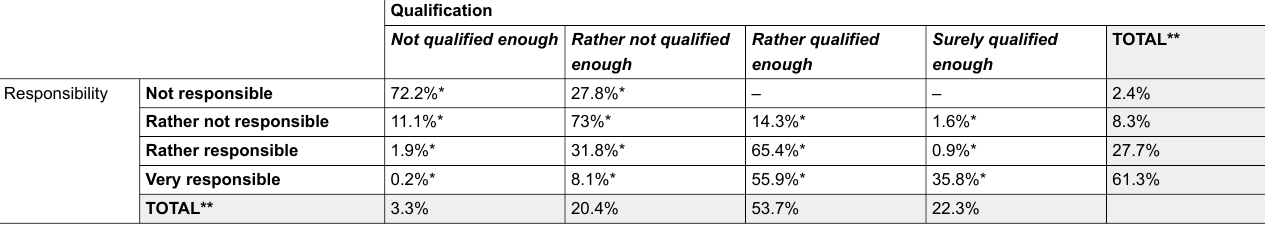
Table 2: Cross tabulation: Responsibility and qualification for conducting DMC